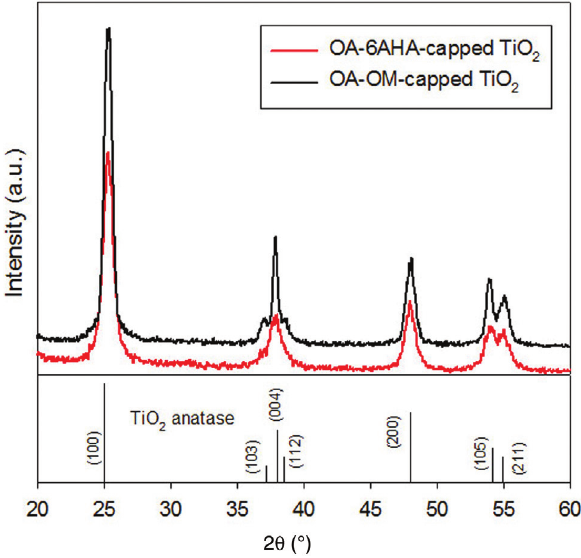
(A1), OA-6AHA-capped- 2